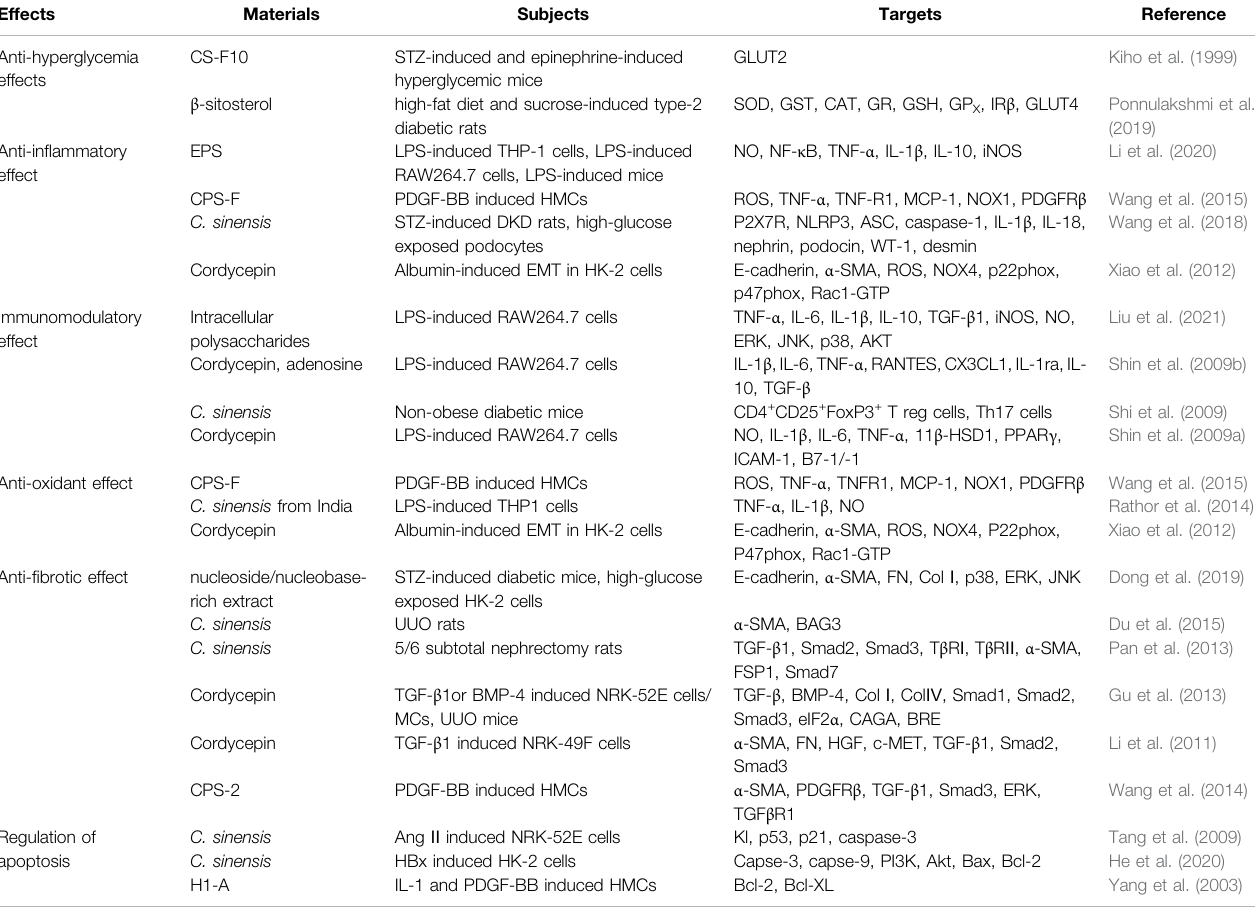
TABLE 2 | Major effects and targets of Cordyceps Sinensis in Diabetic Kidney